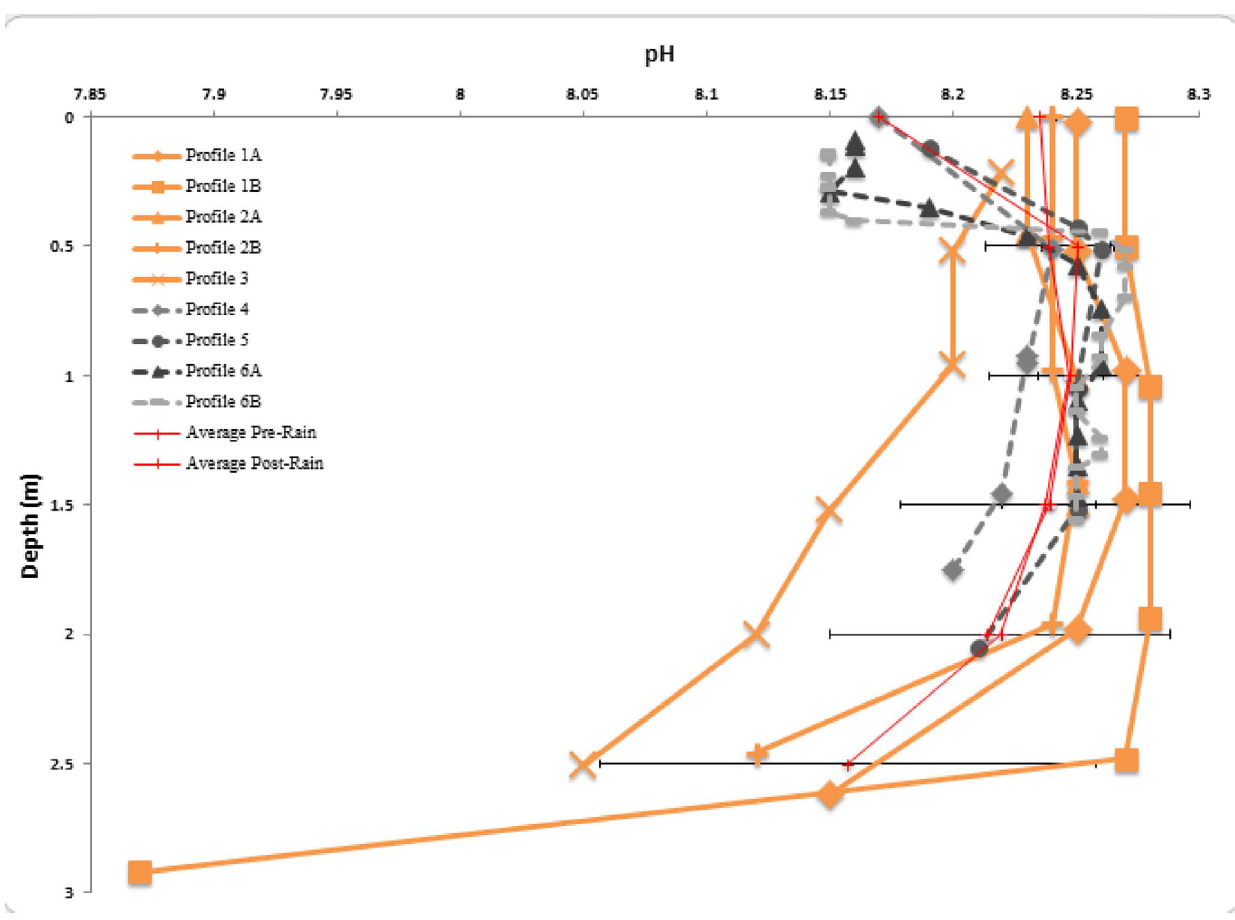
Figure 4. pH Profiles. Depth profiles of measured pH, July 21–23, prior to significant rain event (in orange), with July 24–25, following a significant rain event (in gray scale). Also displayed are pre-rain and post rain averages with horizontal error bars representing the standard deviation of the average, on either side.